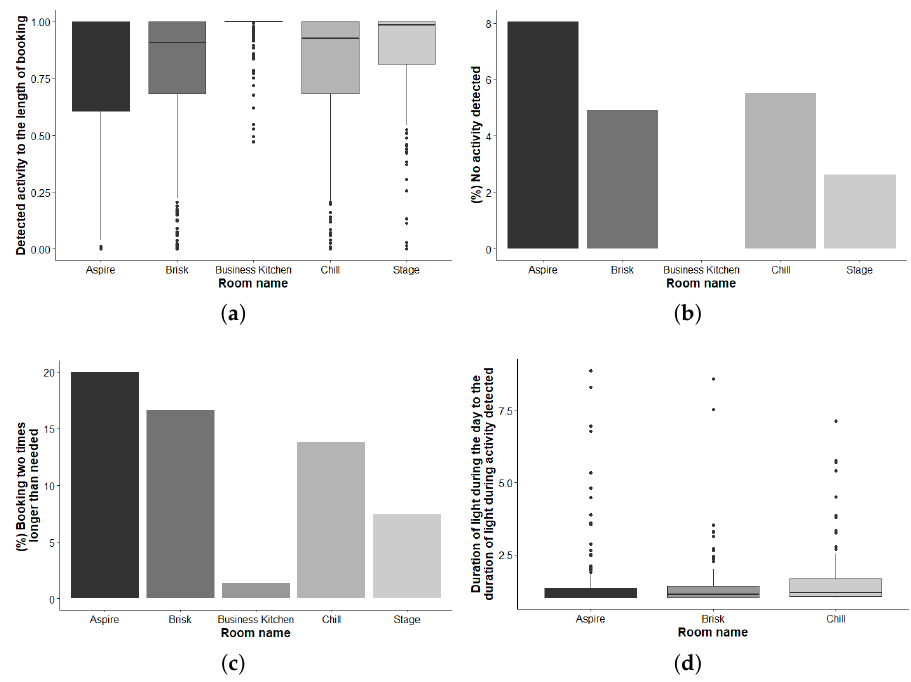
Figure 8. Study results: ( a ) summary statistics for ratio of the time of detected activity to the length of booking; ( b ) percent of cases when no activity was detected (no show) or activity was less than 10 minutes; ( c ) percent of cases when the room was booked for two times longer than needed; and ( d ) summary statistics for ratio of duration of light “on” during the day to the duration of light “on” during activity